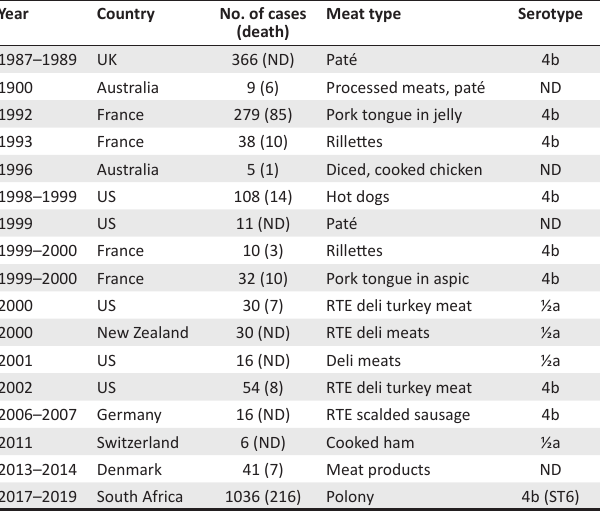
TABLE 1: Major food-borne listeriosis outbreaks because of meat products in the